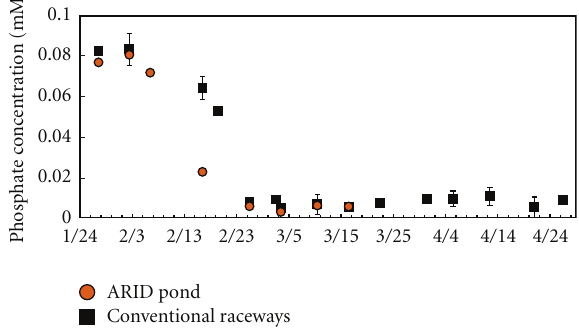
Figure 6: Culture media phosphate concentration as a function of time for the ARID pond and triplicate conventional